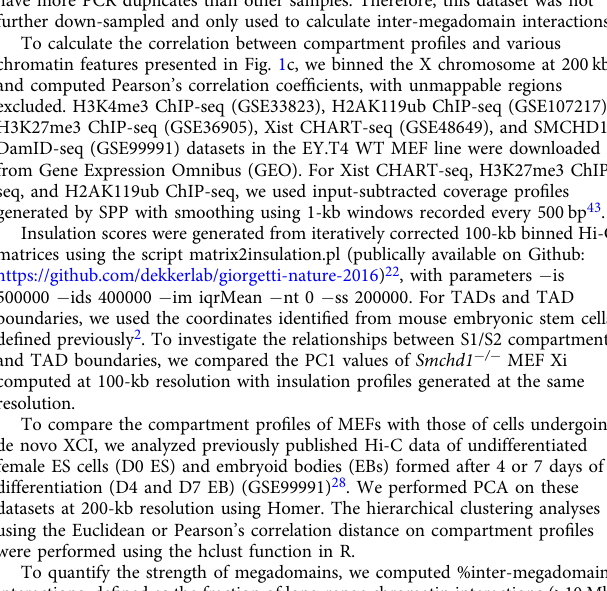
unmappable regions. Also see Supplementary Fig. 13a for the active X chromosome (Xa) maps. d Principal component 1 (PC1) and PC2 values of the Xi. Regions with positive PC1 values represent the S1 compartment or the telomeric megadomain. Gray-shaded areas, unmappable regions. Also see Supplementary Fig. 13b for PCs of the Xa. e Bar plots displaying the fraction of long-range interactions (>10 Mb) that span the Dxz4 megadomain boundary ( “ inter-megadomain ” interactions) under different conditions. Two replicates were analyzed, with P values determined by the t test (unpaired,